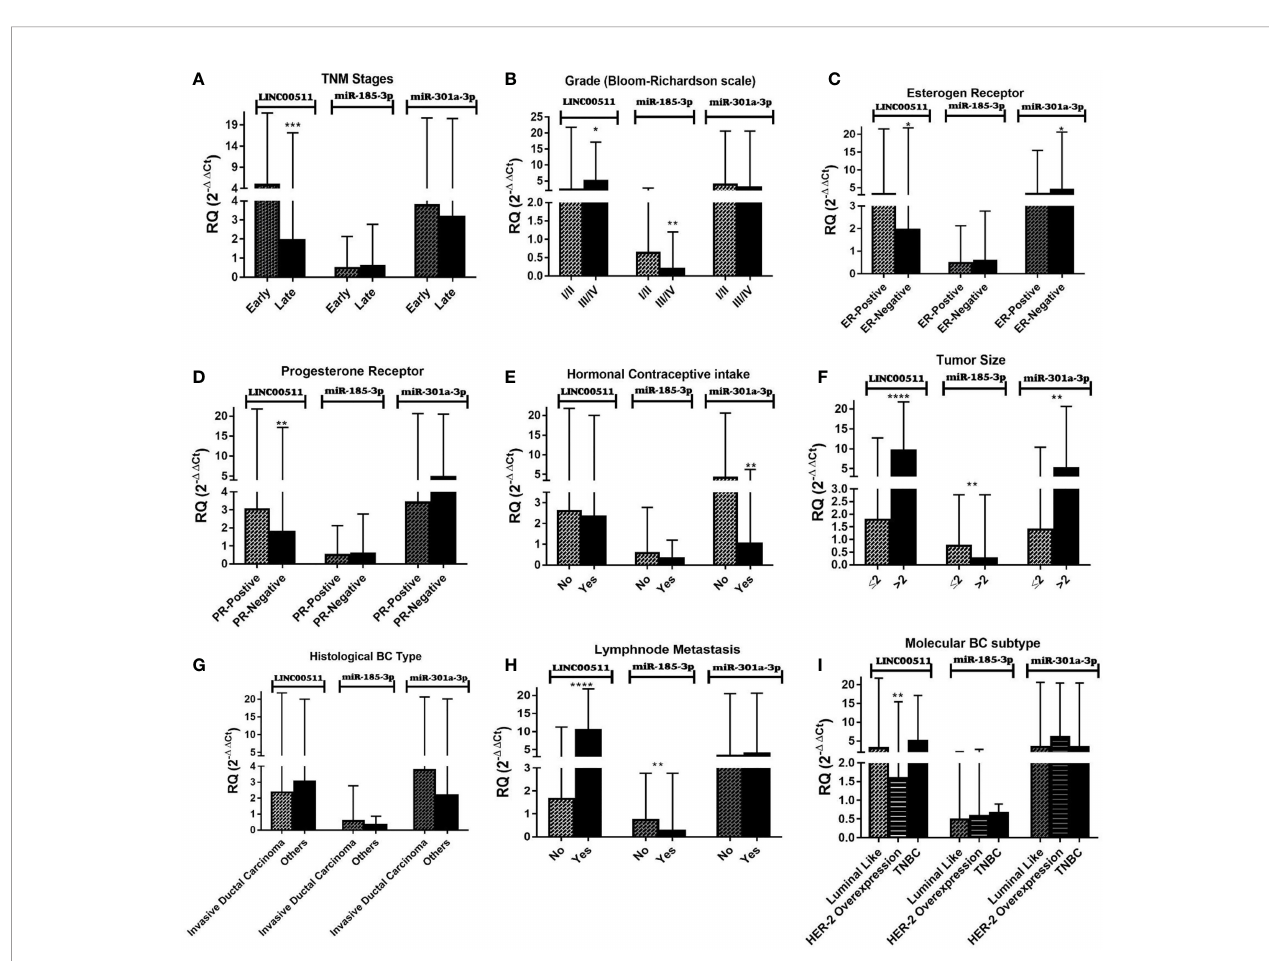
FIGURE 2 | Impact of clinicopathological features on LINC00511, miR-185-3p, and miR-301a-3p expression in BC patients. (A) Early and late stage (TNM, tumor node metastasis), (B) tumor grades (Bloom – Richardson scale), (C) estrogen receptors, (D) progesterone receptors, (E) hormonal contraceptive intake, (F) tumor size, (G) histological BC type, and (H) lymph node metastasis. (I) Molecular BC subtypes. [The Mann – Whitney test was performed. Data are presented as Median (Range). **** p < 0.0001, *** p < 0.001, ** p < 0.01, * p < 0.05, compared with other breast cancer (BC) subgroups using GraphPad prism software].